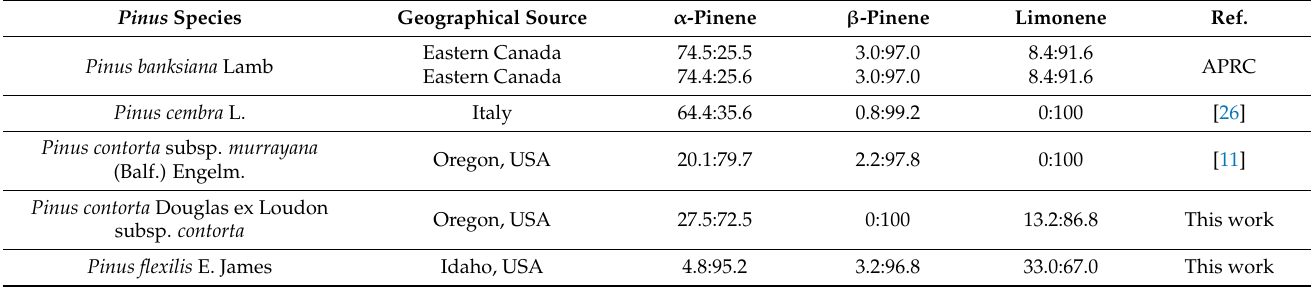
Table 5. Enantiomeric distribution, (+):(–), of monoterpene hydrocarbons in Pinus species leaf essential